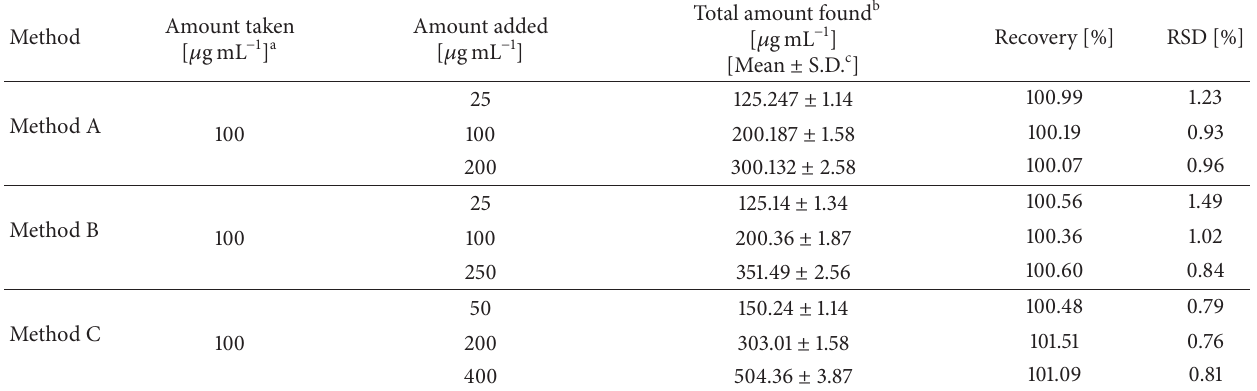
Table 2: Results of recovery studies by standard addition method.